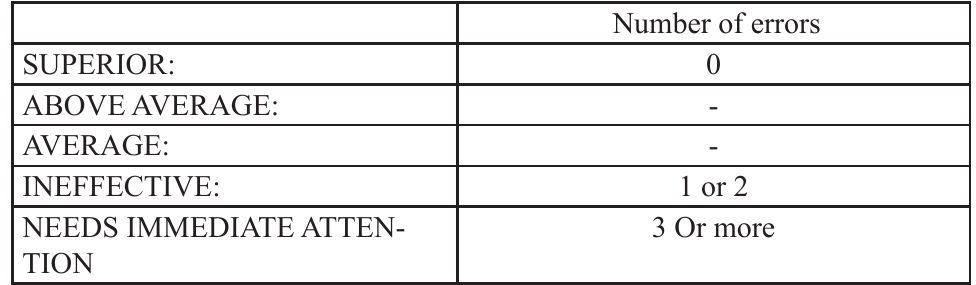
Table 5: The norms obtained for Stereopsis with the use of a Randot Stereo test